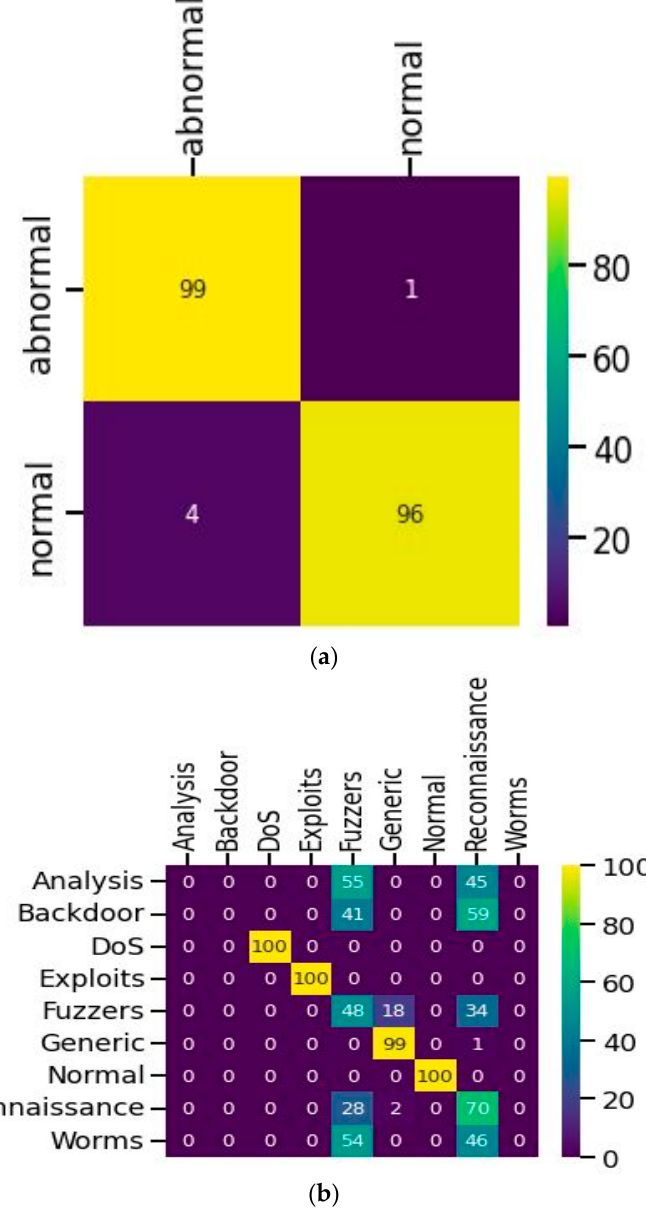
Figure 9. Confusion metrics of the ( a ) Binary and ( b ) Multiclass anomaly detection.